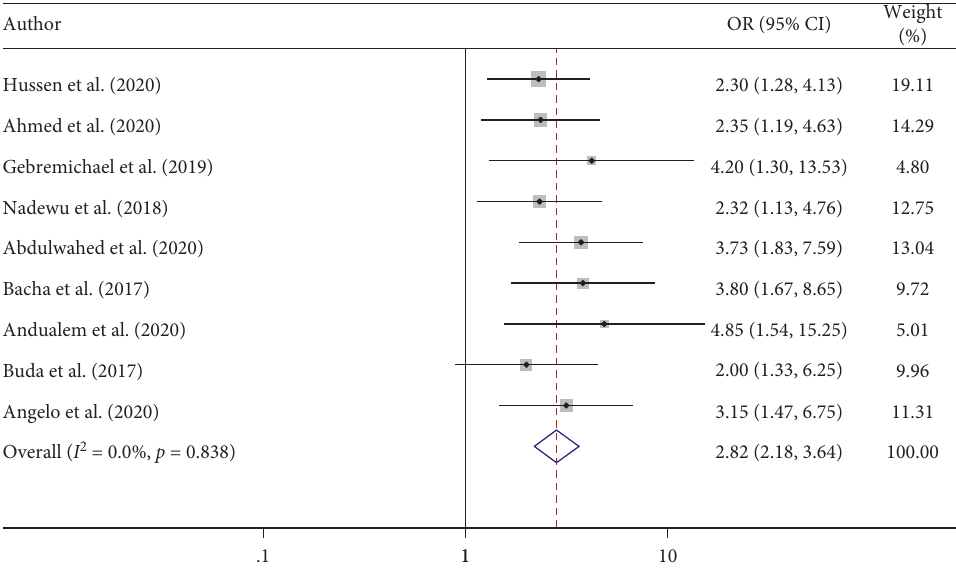
Figure 4: The pooled odds ratio of the association between educational status and self-care practice among hypertensive patients in